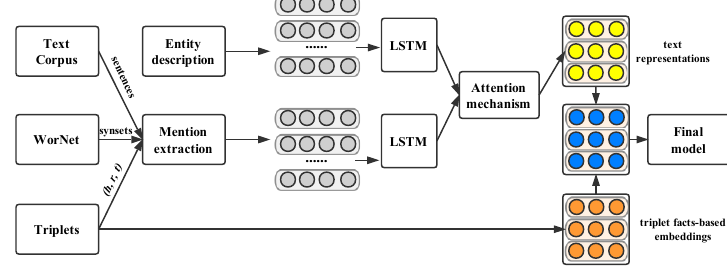
Figure 6. Framework of text-enhanced KG embedding